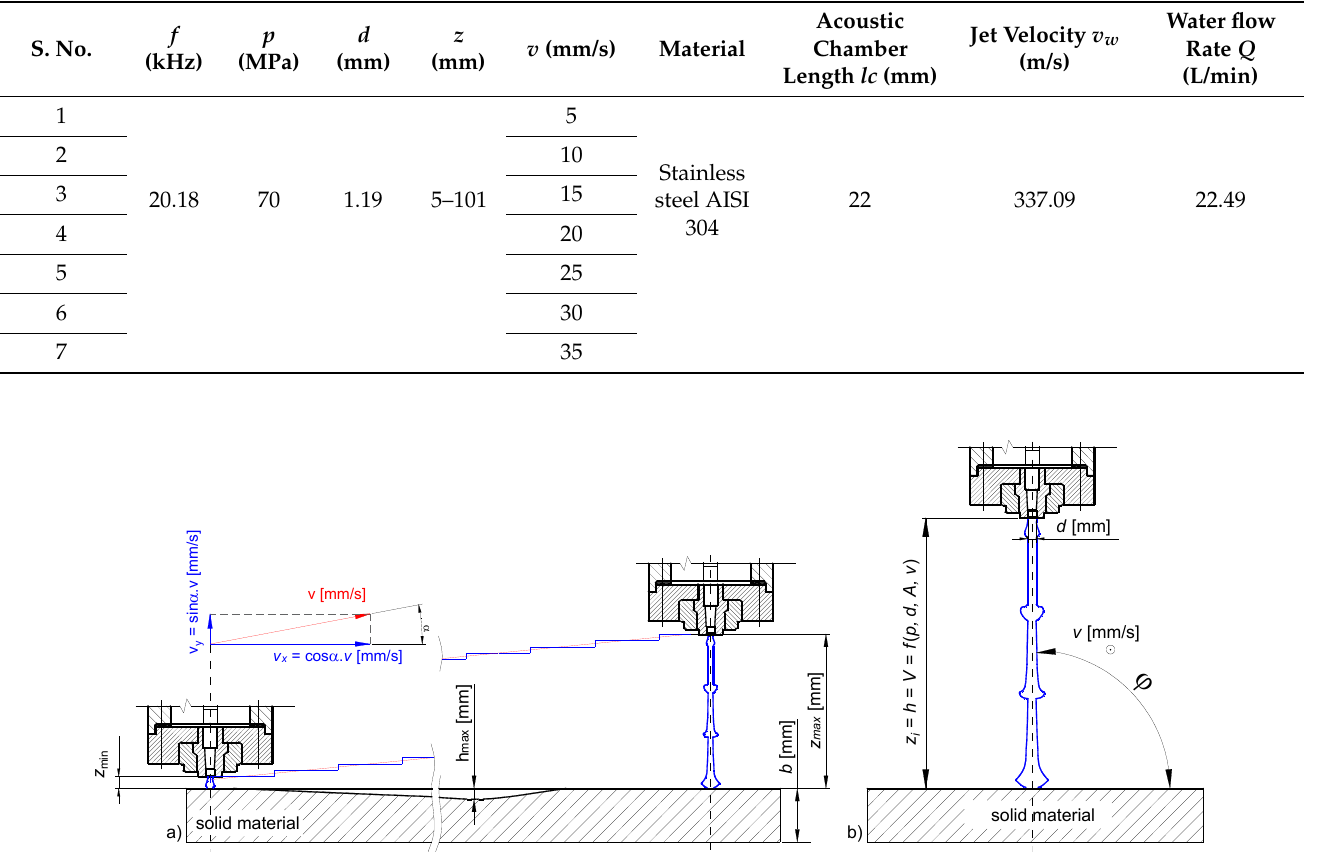
Figure 2. ( a ) Trajectory for the PWJ head; ( b ) PWJ morphology.